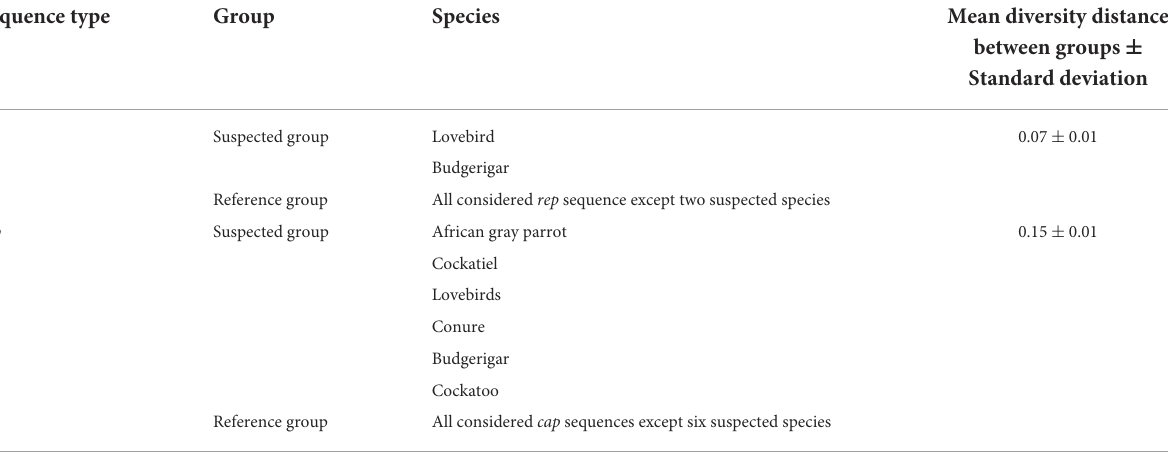
TABLE 3 Mean diversity distance between suspected species and reference groups including GenBank and non-suspected